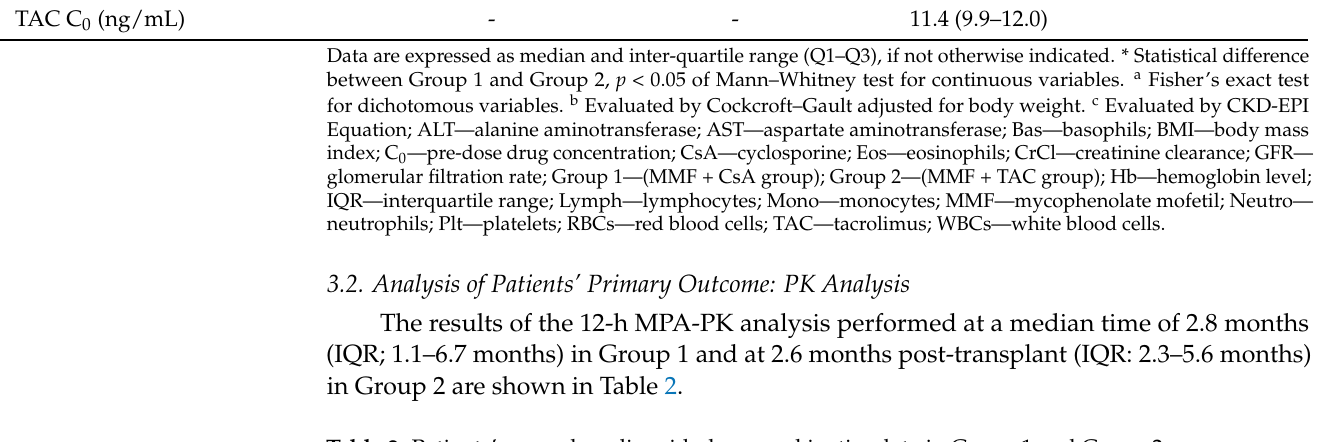
Table 2. Patients’ mycophenolic acid pharmacokinetics data in Group 1 and Group